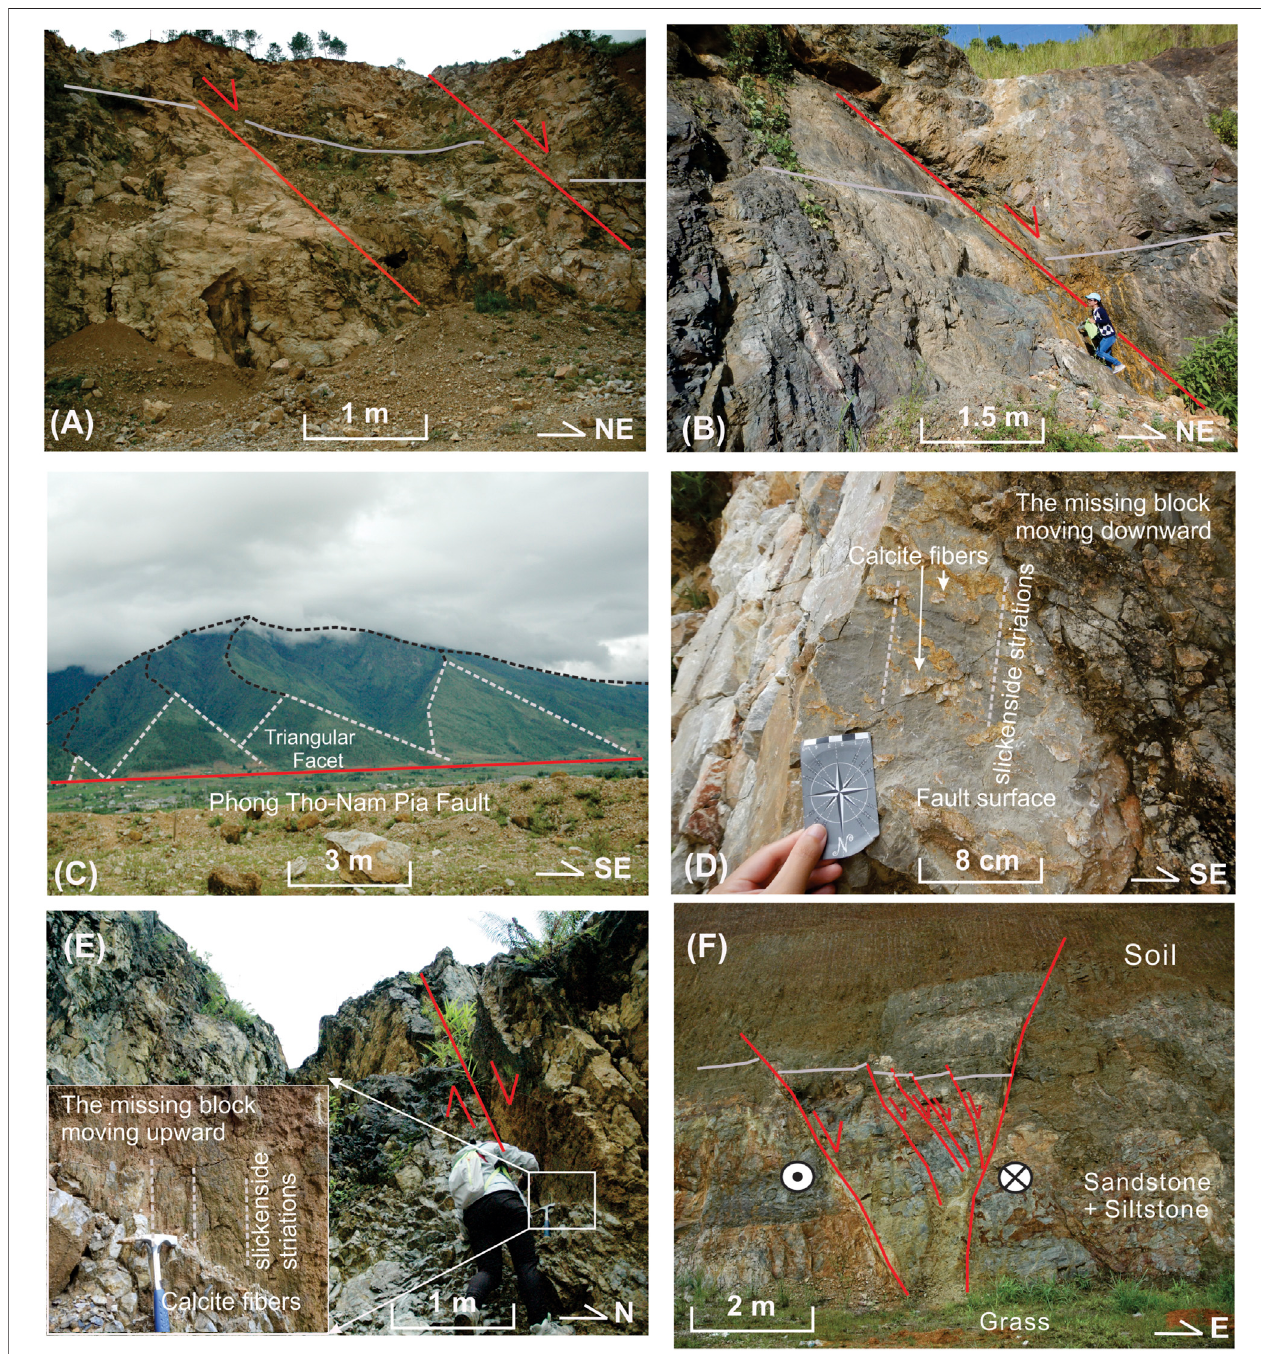
FIGURE8|(A,B) NormalfaultsexposedalongroadcutsinoutcropsVN01andVN04,respectively; (C) FiledphototakinginthemountainfrontoftheSWsideofthe Fansipan mountain range showing triangular facet pattern; (D, E) Calcite slickensides on the fault planes indicating normal fault movement in outcrops VN02 and VN03, respectively; (F) Negative fl ower structure in outcrop VN05 shows extensional movement with a combination of normal and left-lateral movements in the Nghia Lo area.